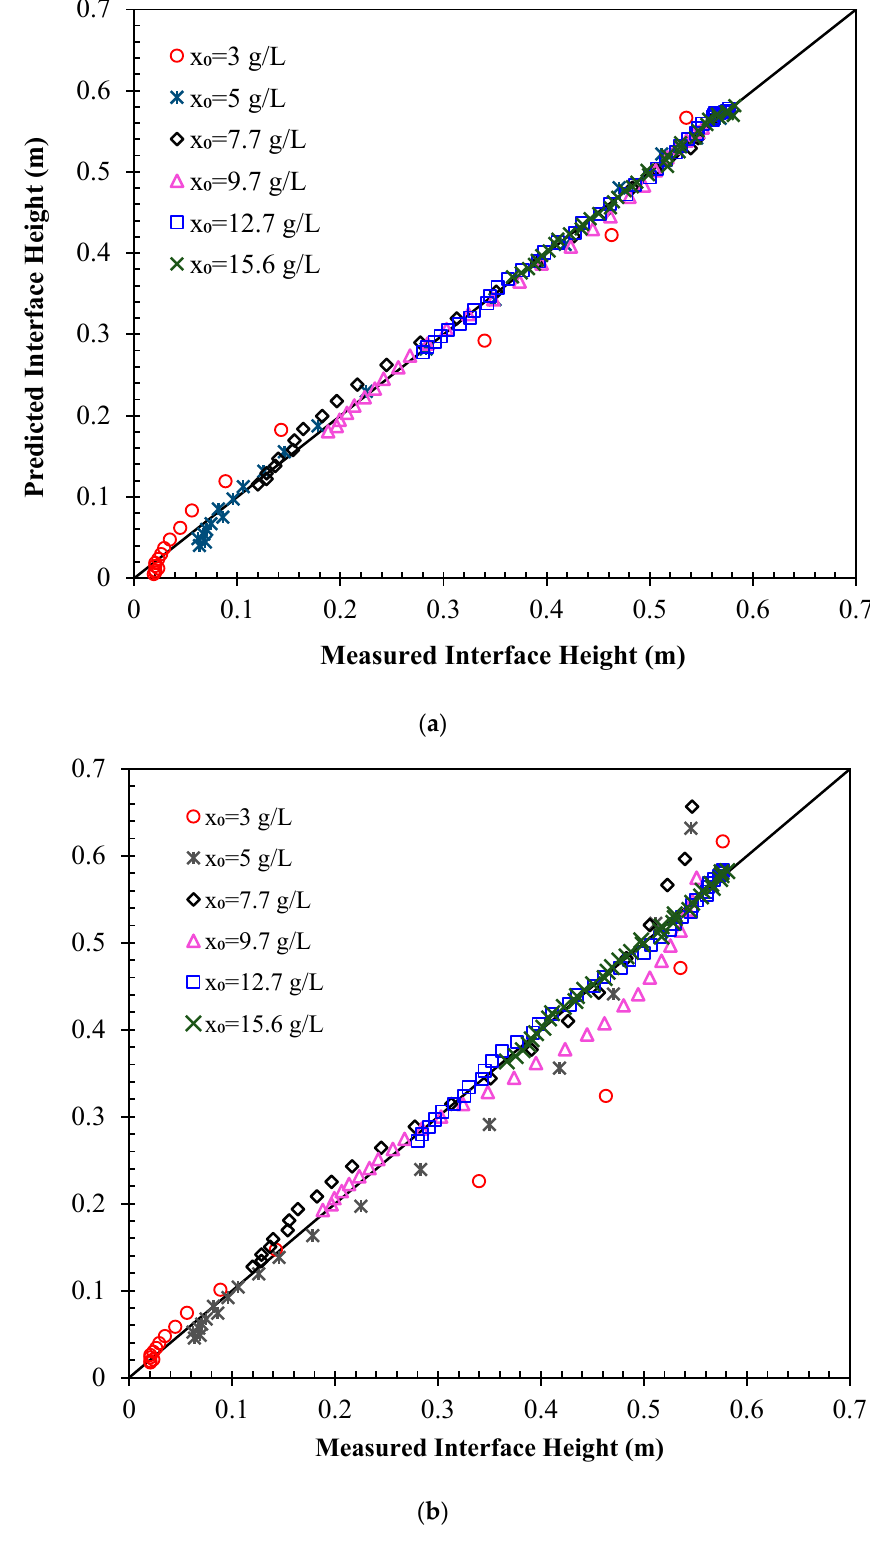
Figure 6. Parity plots comparing the measured solid settling data, borrowed from [21], with the predicted data using ( a ) the VM-based model (Equations (6)–(10)) and ( b ) LM-based model (Equation (11)).